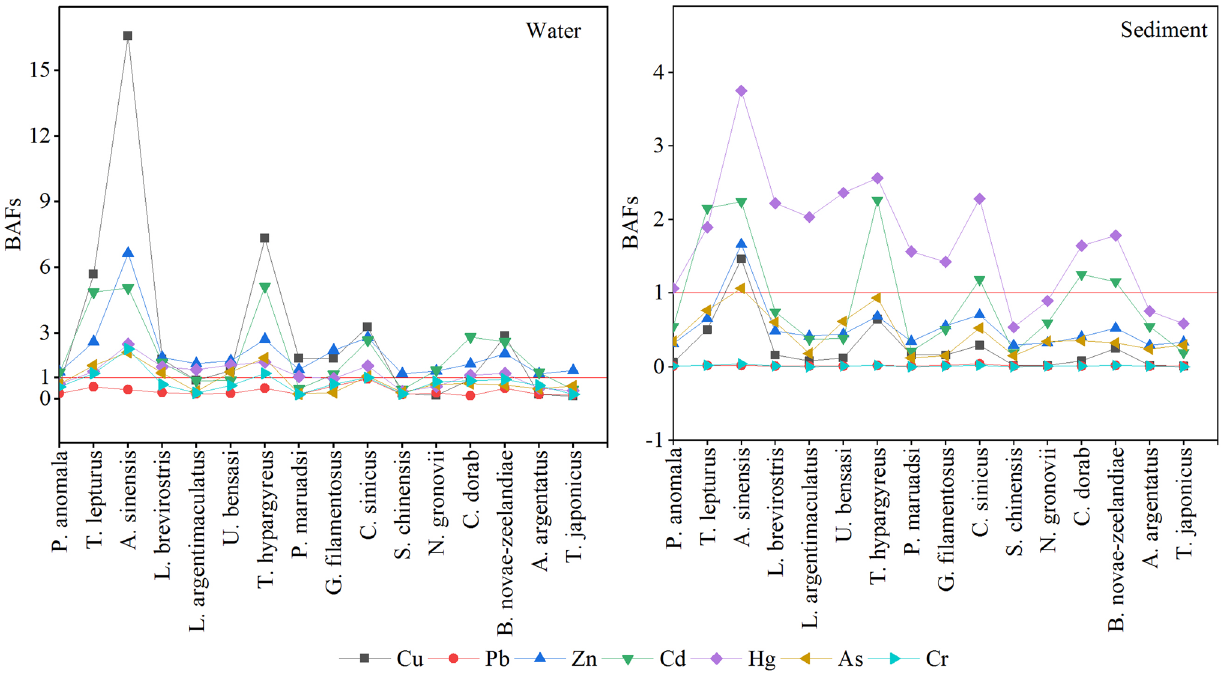
Figure 4. Bioaccumulation factors (BAFs) in the fish samples collected from Xincun Lagoon, South China